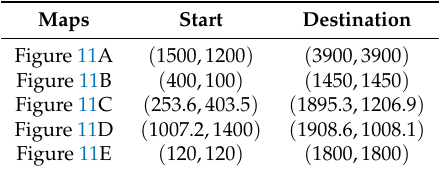
Figure 11. Five maps are used to test the algorithm. These maps have various obstacles. Table 1. The start and destination of the